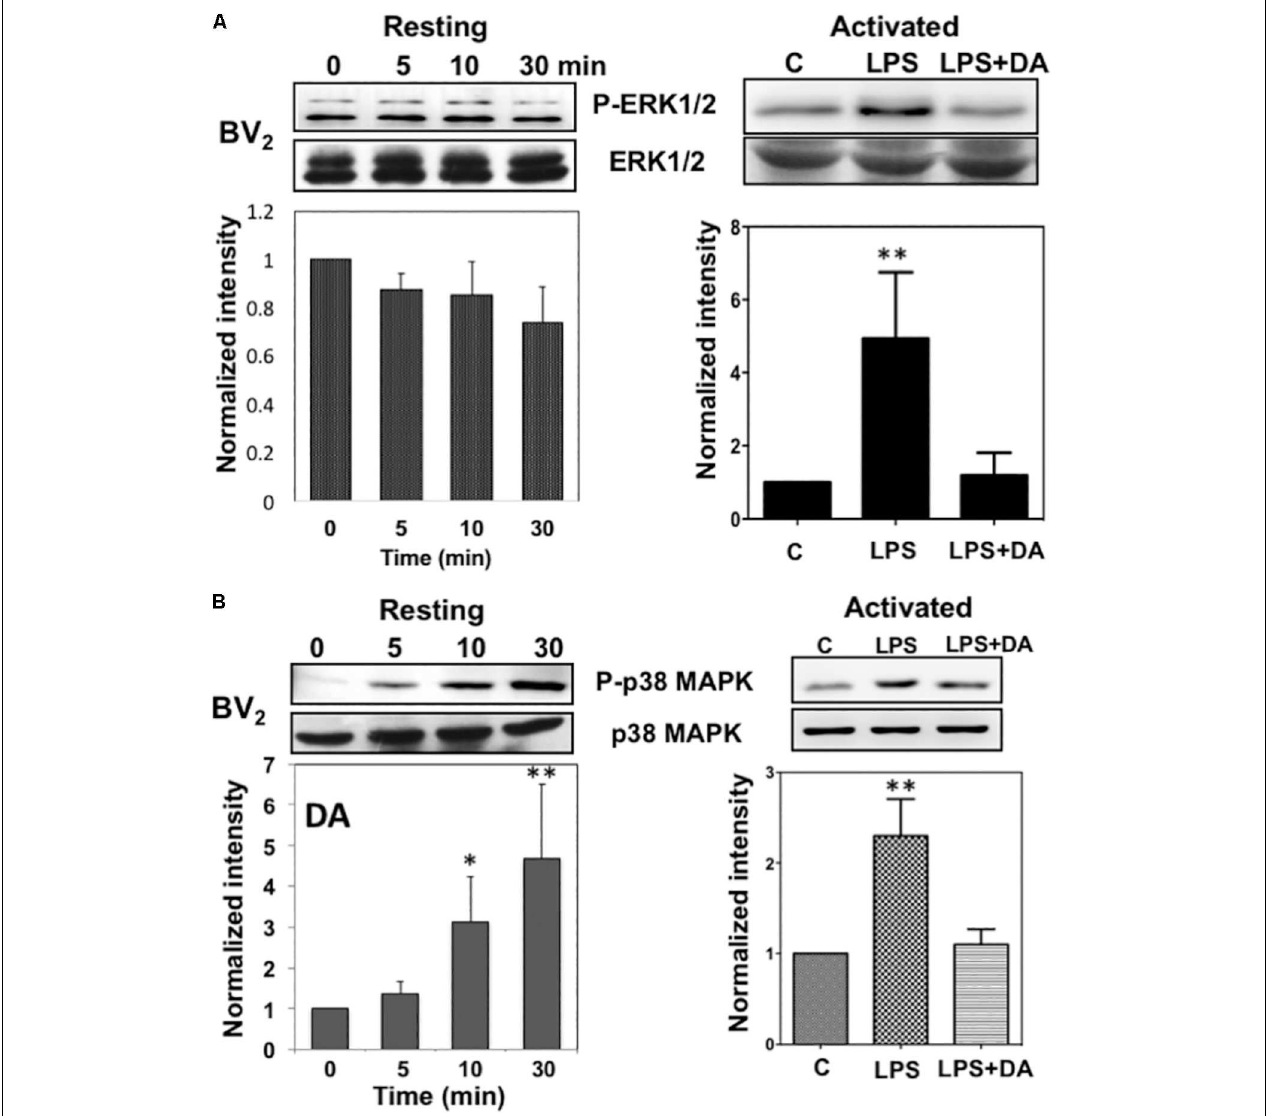
FIGURE 4 | Immunoblot analysis of the activation of ERK1/2 and p38MAPK in resting and activated microglia. (A) Activation of ERK1/2 upon DA stimulation in resting and activated Bv2 microglia. Total cell lysates were collected at various time points (5, 10, and 30 min) after DA (2 µ M) stimulation. The lysates were separated by SDS-PAGE, transferred onto PVDF membranes, and immunoblotted with the anti-phospho-ERK1/2 antibody. Immunoblots with anti-ERK1/2 antibody were used for loading control. ERK1/2 were measured as fold increase of the control. Values are means ± standard error of three or four independent experiments. (B) Activation of p38MAPK in resting, but not in activated microglia in response to 2 µ M of DA. Both the resting and activated BV 2 microglia were treated with 2 µ M of DA for 30 min. Total cell lysates were separated by SDS-PAGE and immunoblotted with an anti-phospho-p38MAPK antibody. Values are means ± standard error of four independent experiments. (ANOVA: ∗ P < 0.05, ∗∗ P < 0.01 compared to